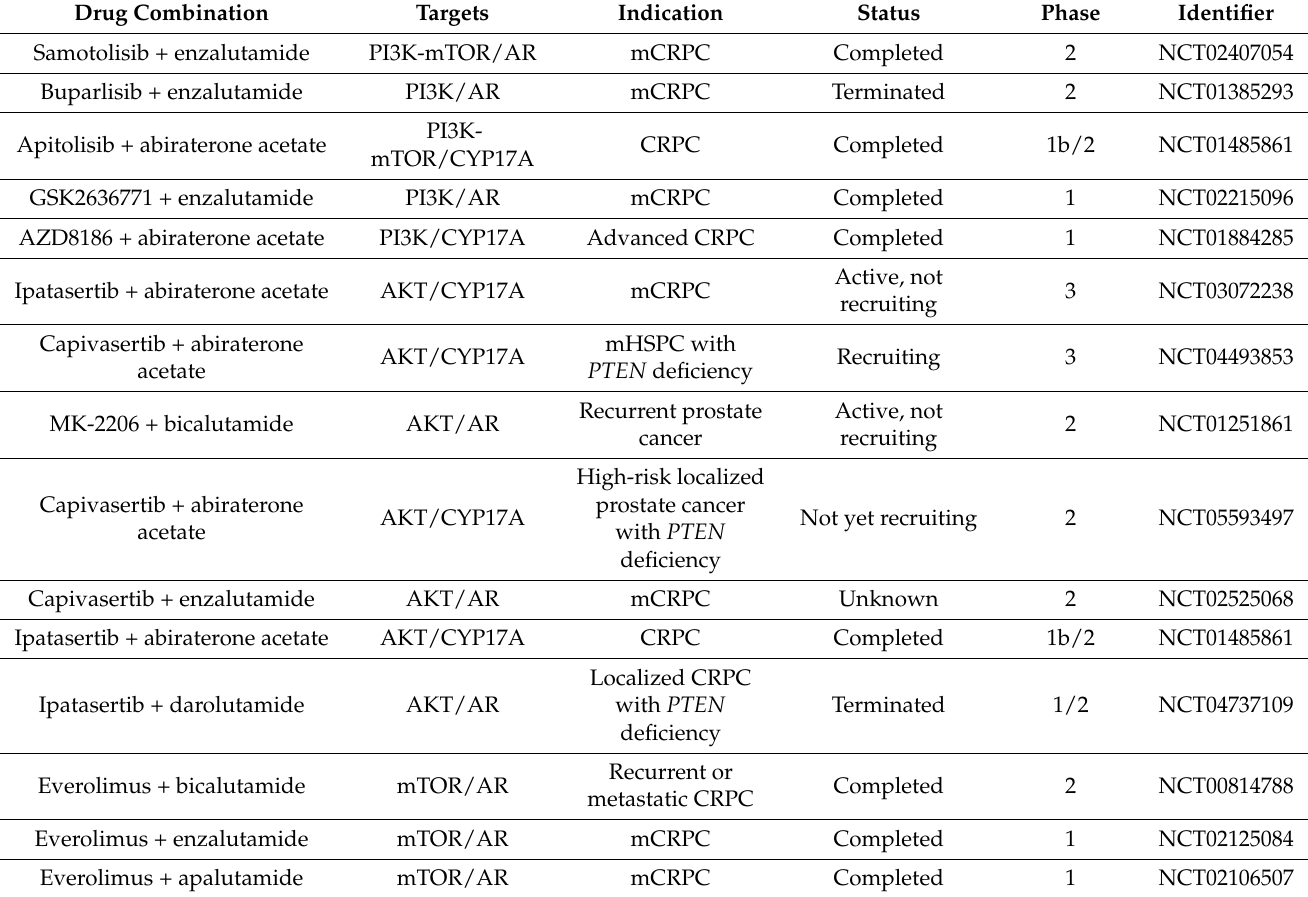
Selection of prostate cancer clinical trials combining PI3K/AKT/mTOR and AR pathway